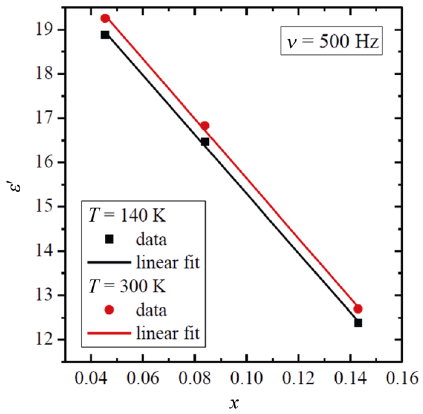
Fig. 13 Dependence of ε  (500 Hz) on x at two temperatures, 140 K and 300 K (  1